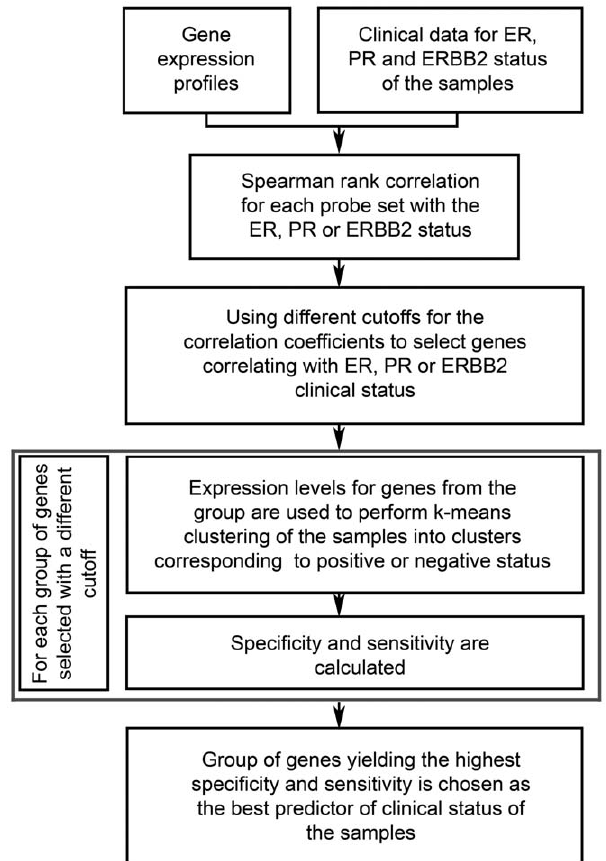
of ER, PR or ERBB2 status. The method was used on HG-U133A GeneChip arrays containing 22,283 probe sets. ER – estrogen receptor; PR – progesterone